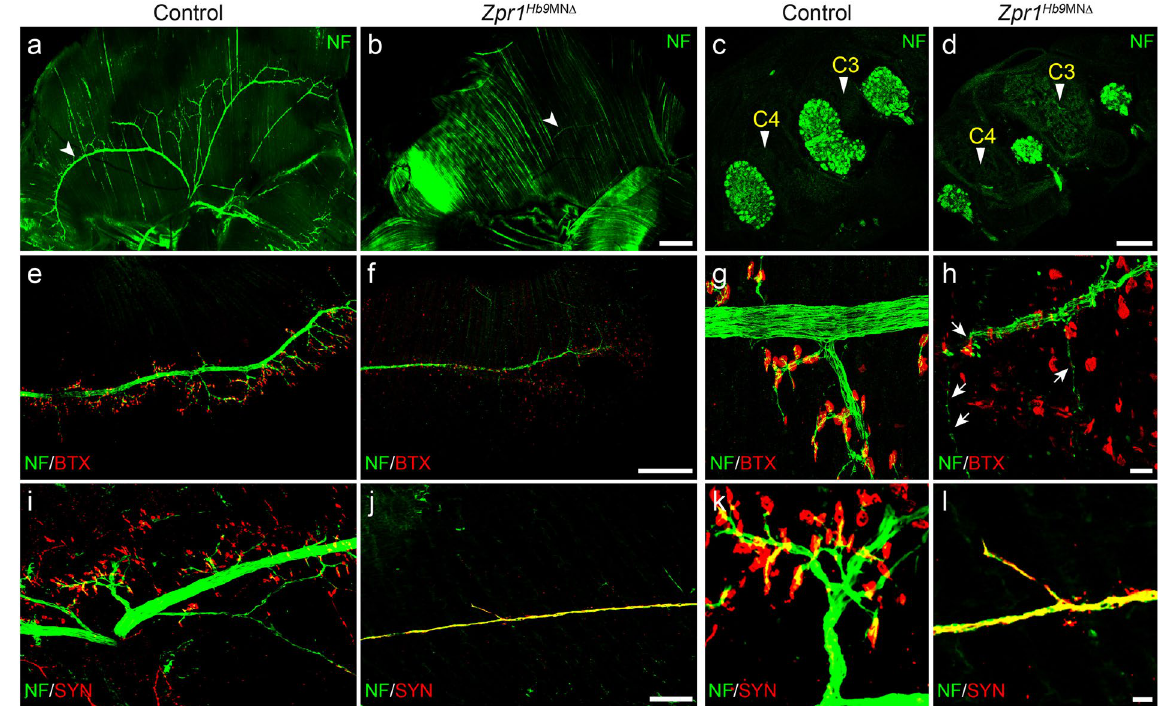
Figure 2. Defects in the development of phrenic nerve and diaphragm innervation in Zpr1 Hb9 MN Δ mice. ( a , b ) Whole diaphragms from E18.5 embryos were stained with neurofilament (NF) antibody. Images shown are composite of individual panels acquired by TileScan using confocal microscope. Immunofluorescence image analysis revealed defects in the development of phrenic nerve in Zpr1 Hb9 MN Δ embryos (arrowheads indicate phrenic nerve). ( c , d ) Analysis of longitudinal sections of spinal cord shows cross section of three bundles of respiratory motor neurons exiting from the C3-C5 region of the spinal cord that form phrenic nerve (arrowheads indicate cervical vertebrae). ZPR1 deficiency results in marked reduction in the size of all three bundles of motor axons, indicating ZPR1 is required for the development of phrenic motor neurons. ( e , h ) Analysis of diaphragms stained with NF and α -bungarotoxin (BTX) shows defects in the innervation of neuromuscular junctions (NMJs) by motor neurons in mutant embryos. The phrenic nerve reached diaphragm muscle but failed to generate secondary and tertiary branches and innervate NMJs in mutant embryos. Phrenic nerve degeneration was detected in mutant embryos (arrows). ( i - l ) Staining with NF and synaptophysin (SYN) show severe defects in the formation synapse in mutant embryos, a likely cause of stillbirth of Zpr1 Hb9 MN Δ mice. Scale bars are 500 μ m ( a , b ), 250 μ m ( c , d , e , f ), 100 μ m ( i , j ) and 12.5 μ m ( g , h , k , l